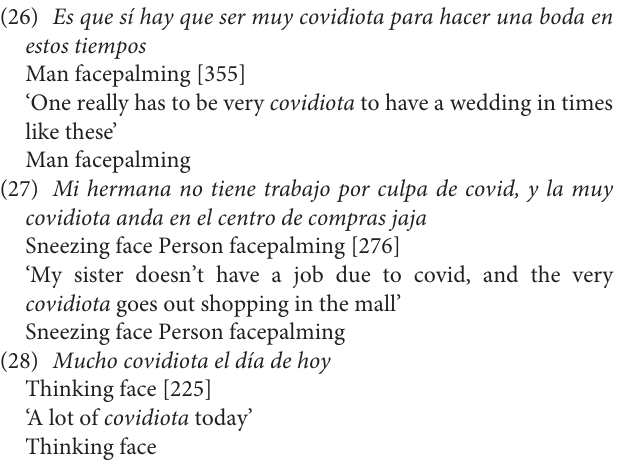
the phrases from the covidiota -corpus ( andar de covidiota ,